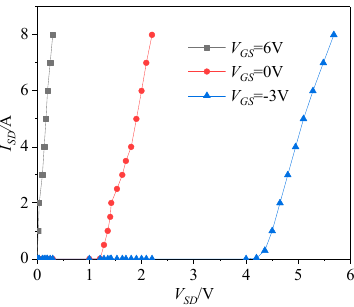
Figure 3. Experimentally measured GaN reverse conduction characteristics. Figure 3 . Experimentally measured GaN reverse conduction characteristics